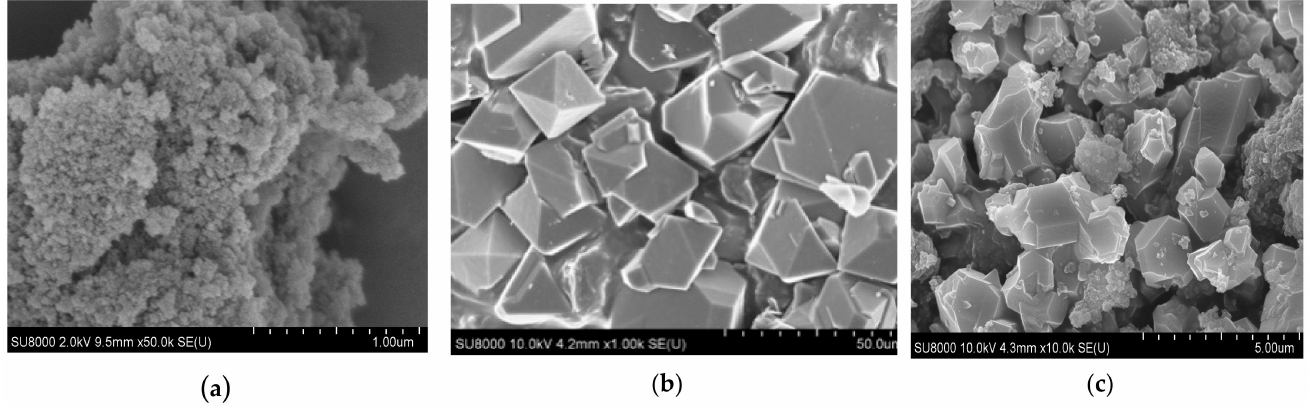
Figure 1. SEM micrographs of the bare BPS ( a ) and pristine HKUST-1 mw ( b ) components and HKUST-1@BPS (sample 1 ) composite material ( c